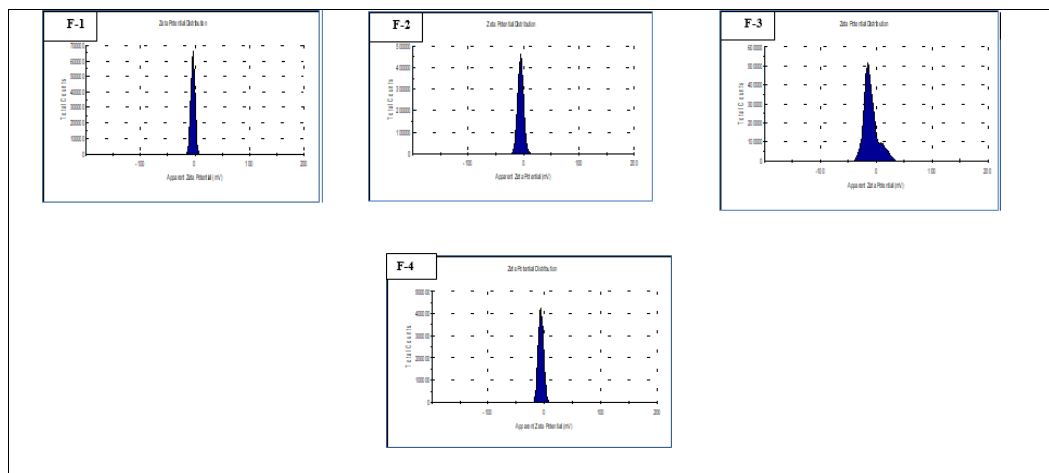
Figure 7. Zeta potential values of lacidipine NEs formulas (1,2,3 and 4) respectively.